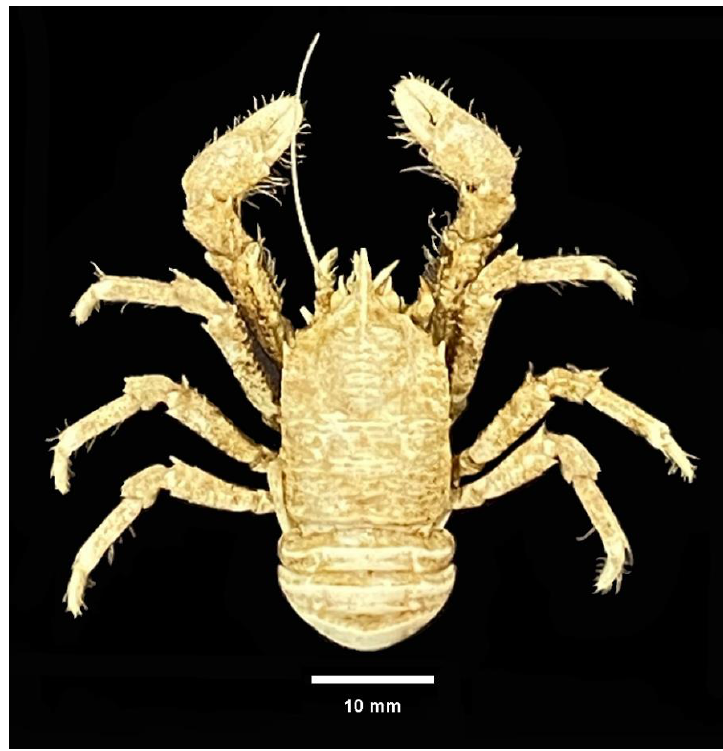
Figure 1. Munidopsis lauensis Baba and de Saint Laurent, 1992.